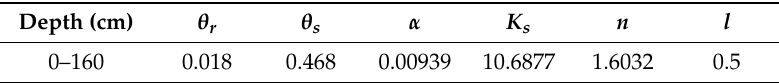
Table 1. The parameters of the model soil